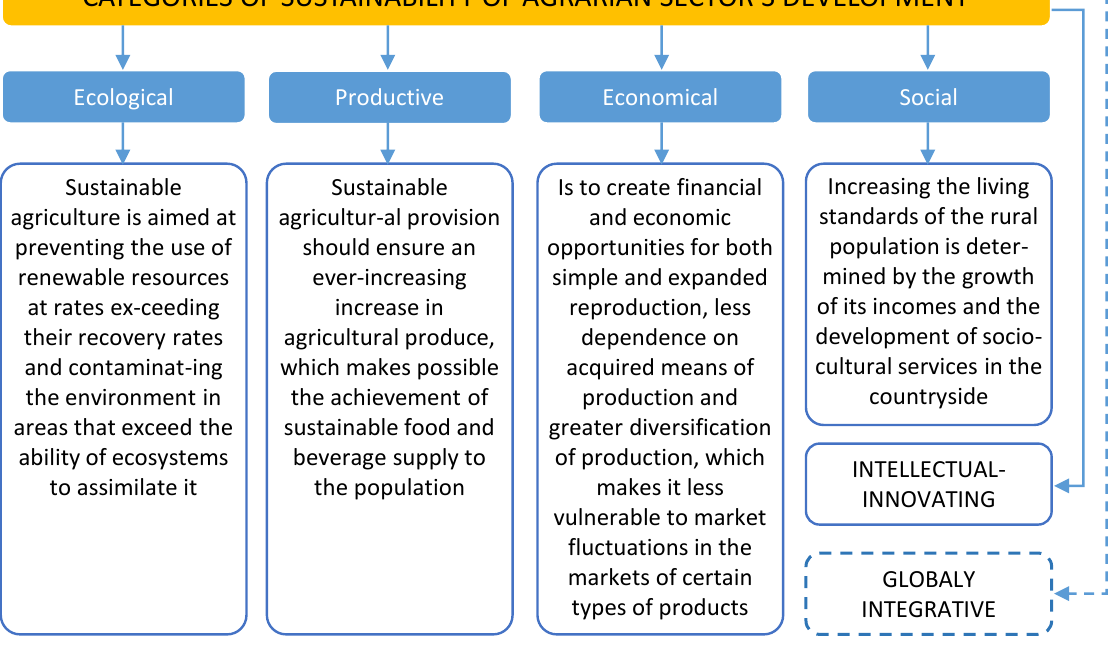
Figure 2. The categories of “sustainable development of the agrarian